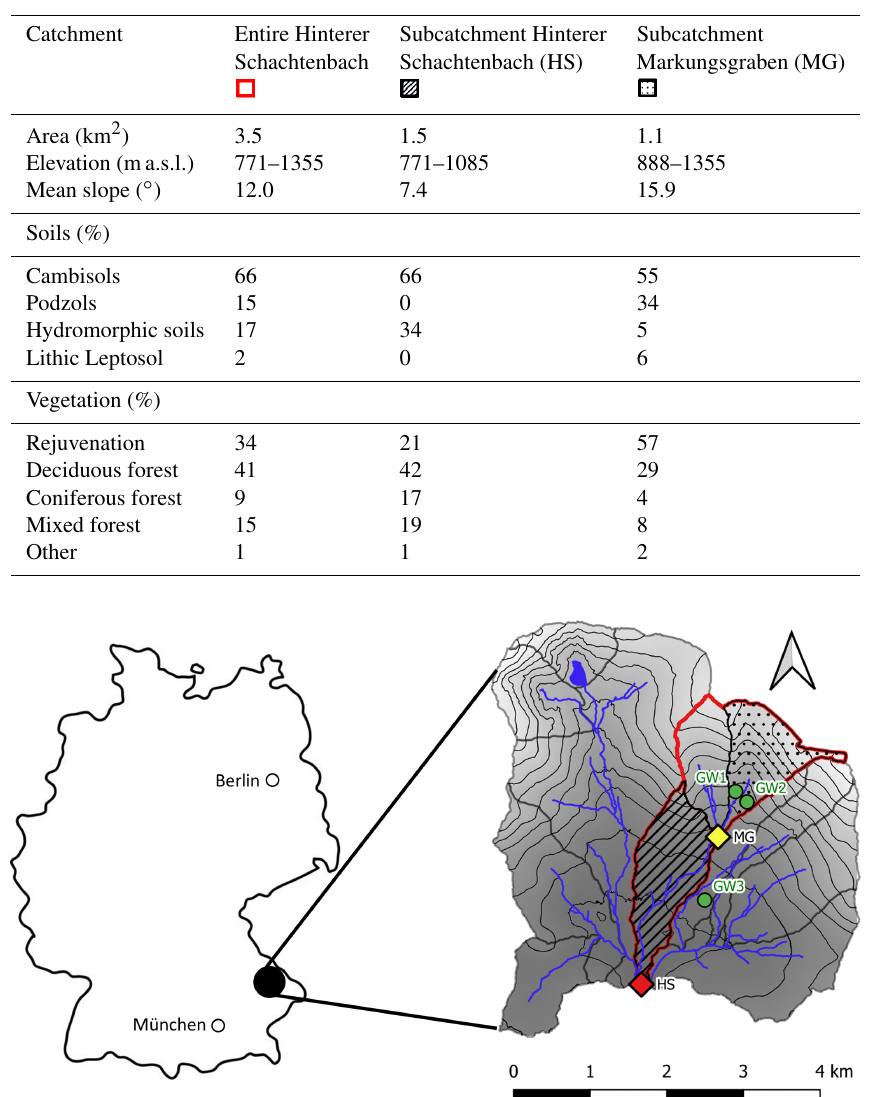
Table 1. Characteristics of the entire Hinterer Schachtenbach catchment and the studied subcatchments of Hinterer Schachtenbach (HS) and Markungsgraben (MG). The subcatchment of Kaltenbrunner Seige was not included in the monitoring. The colored squares represent the subcatchments shown in Fig. 1.